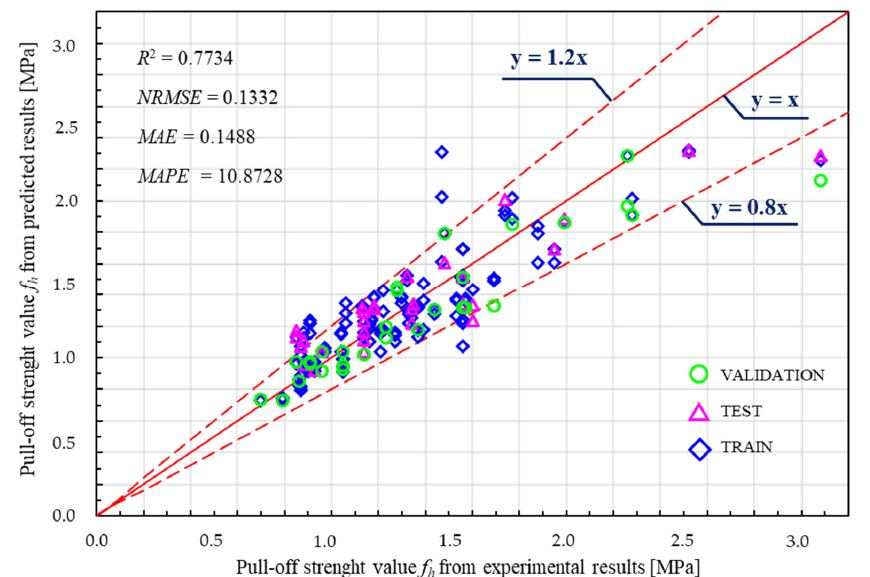
Figure 14. Relationship between the predicted value and the experimental value of the pull-off strength f h for ANN test, train, and validation process for the CG algorithm with two layers of hid- den neurons.